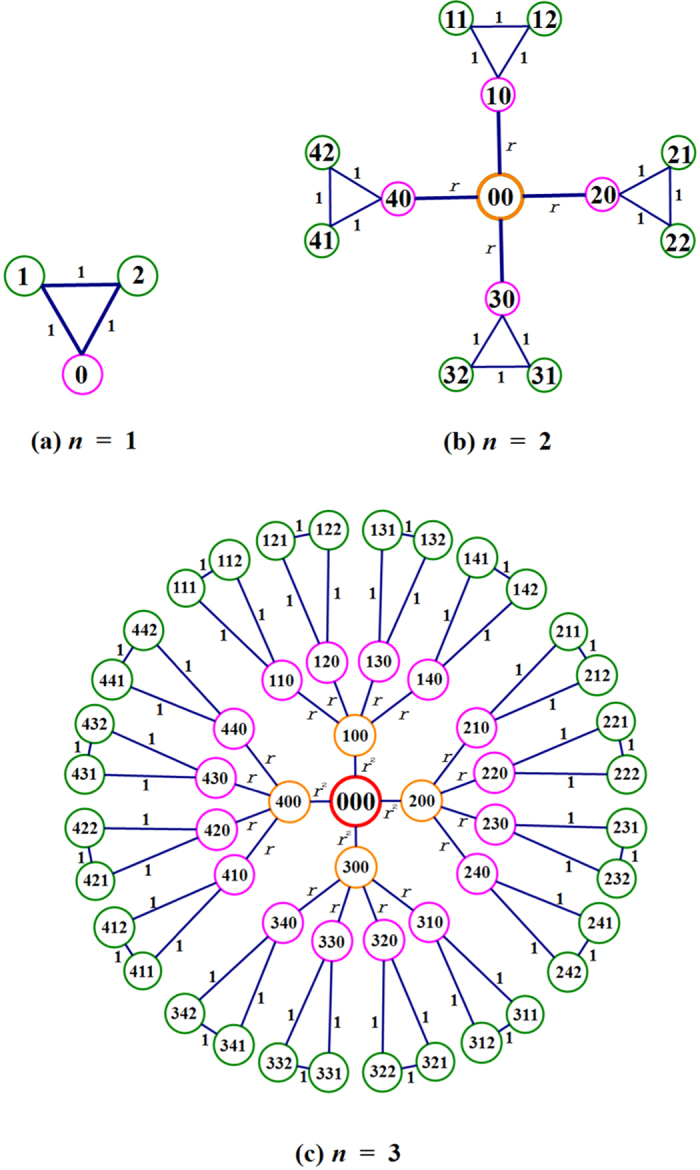
Take the ‘Cantor dust’ weighted fractal networks for example.